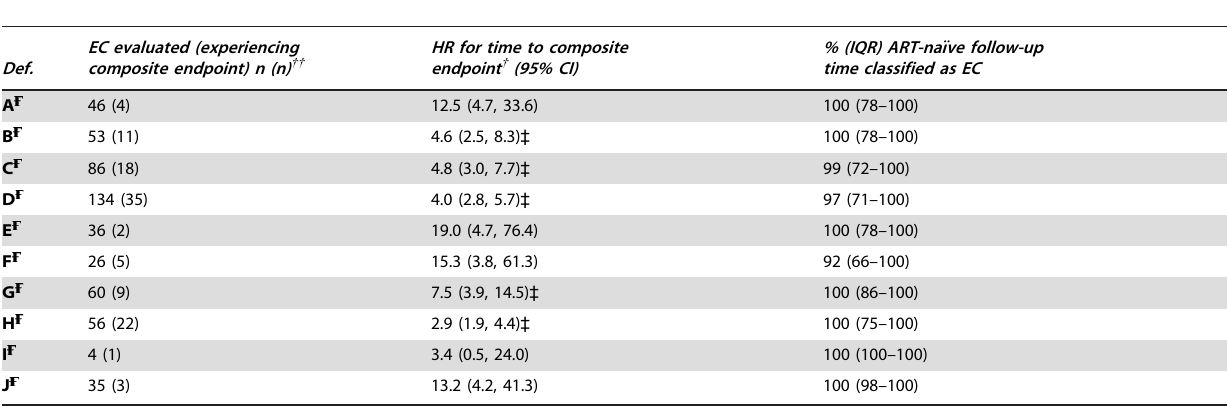
Table 4. Estimated hazard ratios comparing non-elite controllers (EC) and unknown to EC for time from estimated HIV seroconversion to a composite endpoint of AIDS, Death, ART, or CD4 , 350 cells/mm 3 restricting entry to the risk set at 10 years post seroconversion using the CASCADE dataset applied to 10 definitions of EC found in the literature.